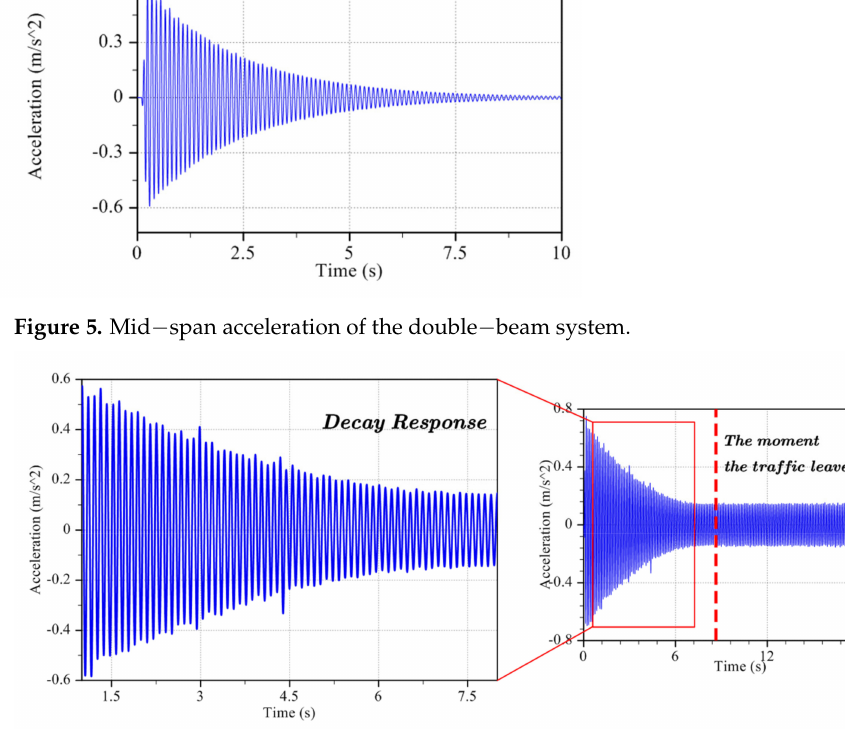
Figure 6. Bridge mid − span acceleration for VBI model (results after bandpass filtering; vehicle speed was 20 km/h).